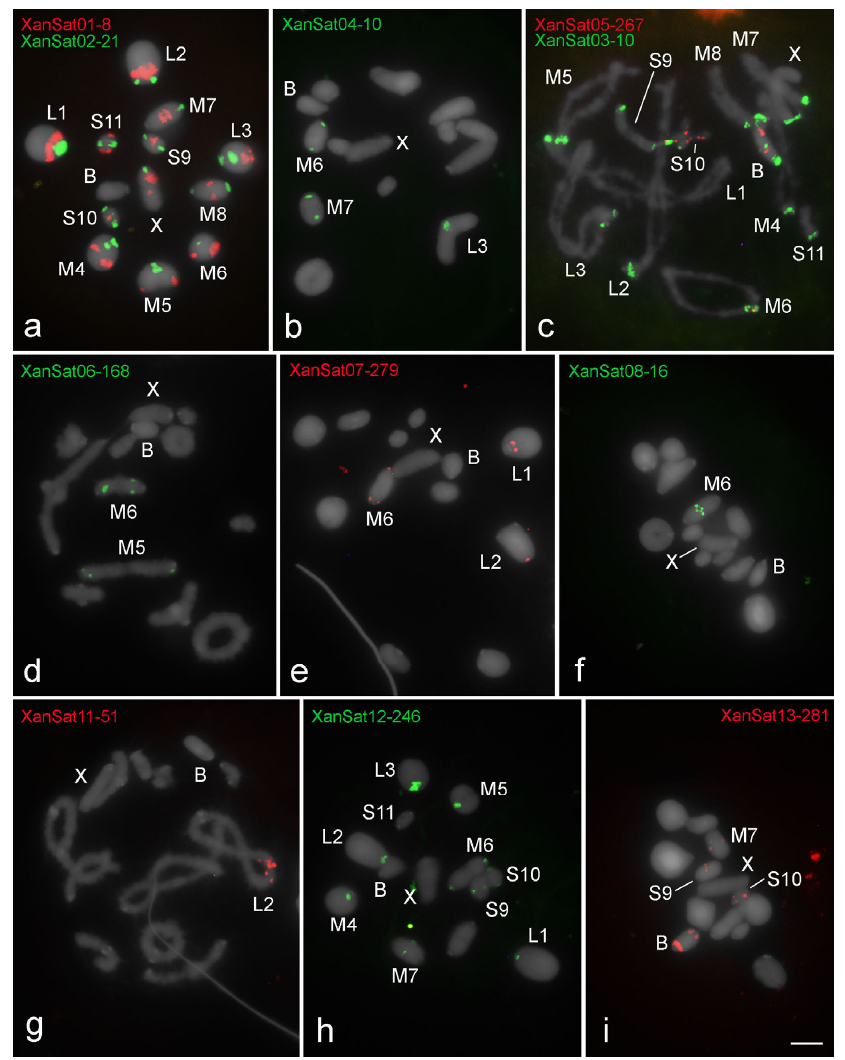
Figure 4. Patterns of chromosomal location revealed by FISH of eleven clustered satDNAs in X. d. angulatus . ( a , b , d – f , h , i ) metaphase I, ( c , g ) diplotene. The distinct satDNAs families are indicated. Chromosomes with signals: X and B chromosomes are identified. Note only three satDNA families on the B chromosome, XanSat03-10 ( c ), XanSat05-267 ( c ) and XanSat13-281 ( i ), all of which shared the pair S10. Multiply satDNA sites are observed for all satDNAs ( a – e , h , i ), except XanSat-08-16 ( f ) and XanSat11-51 ( g ). Bar = 5 μ m.